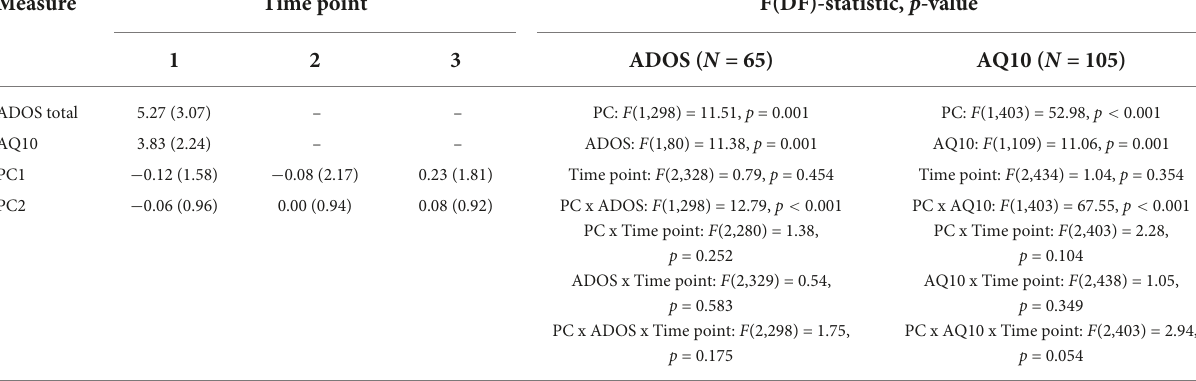
TABLE 2 Association between Time 1 ADOS total and AQ10 scores, and ED symptom profile across time points.